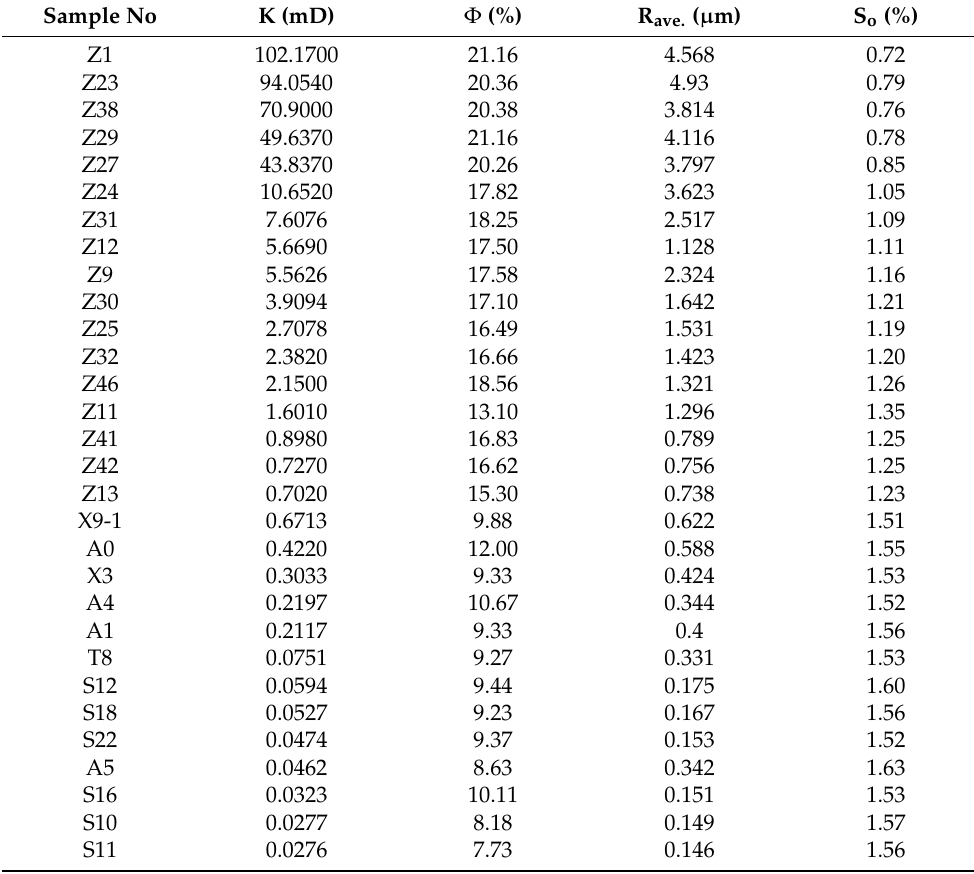
Table 1. The permeability, porosity, average pore throat radius and sorting coefficient results of the sandstone samples.